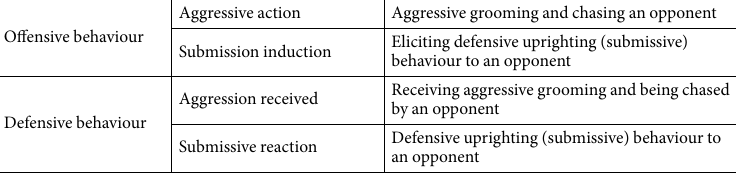
Table 1. Definition of agonistic